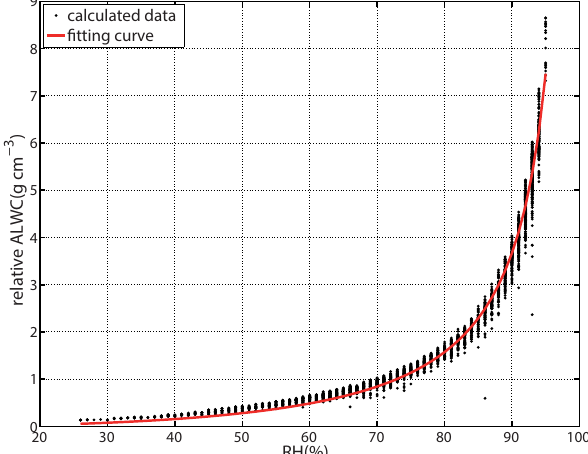
Figure 5. The relationship between relative ALWC and RH. Rela- tive ALWC is defined as the mass of water absorbed by unit volume of dry aerosols. The black dots represent the relative ALWC calcu- lated with ALWC and aerosol volume concentration. The red line shows the curve fitted with Eq. (7).